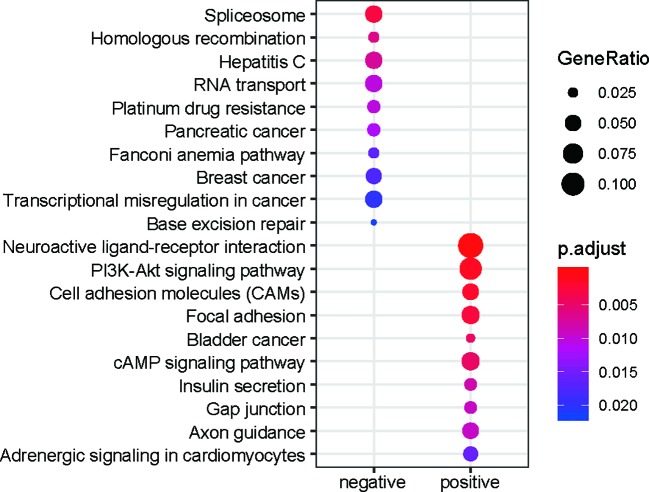
KEGG enrichment of the prognostic genes. The node size represents the ratio of the genes in the pathway. The colors represent the statistical significance of the pathways.